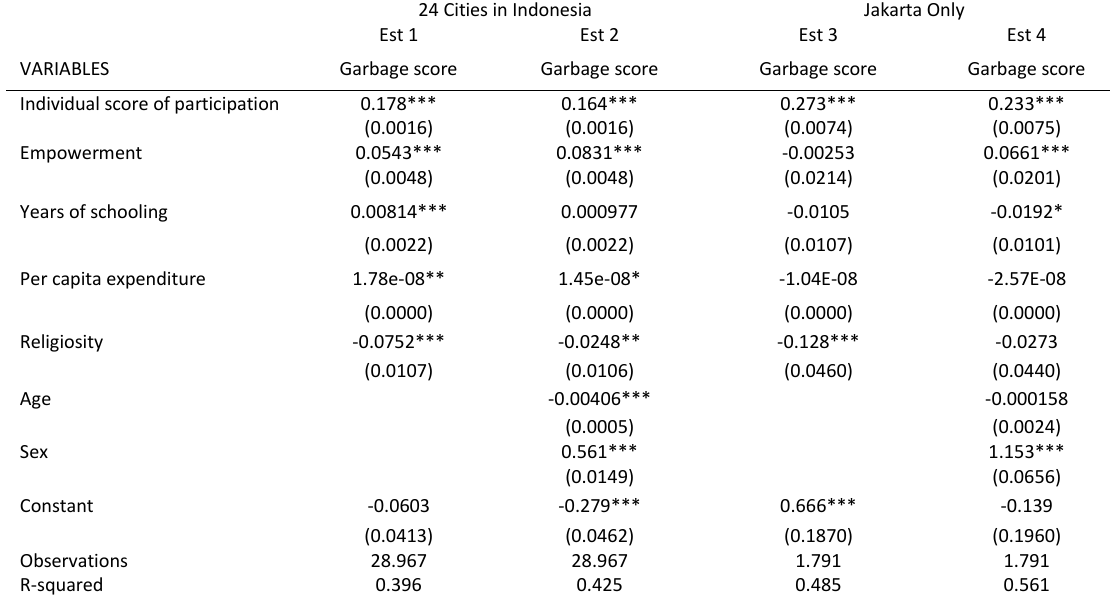
Table 2: Regression results of the waste management awareness score